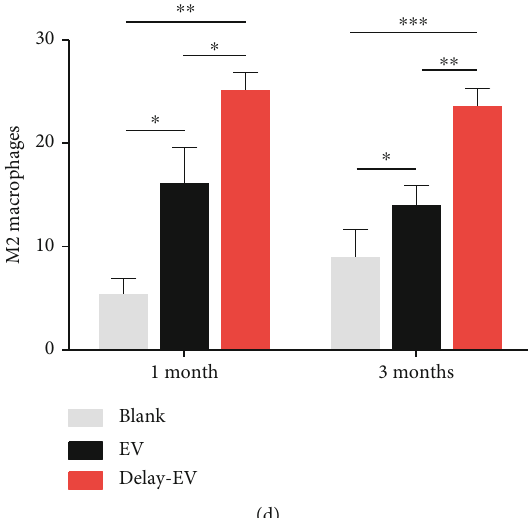
Figure 6: Immunohistochemical staining for fat transplants after 3 months. (a) Immunohistochemical staining images (CD31, Ki67, and CD206) of grafts slices taken from three groups at month 3. Scar bar = 50 μ m . Quantitative analysis of (b) CD31-positive vessels, (c) Ki67-positive cells, and (d) M2 macrophages of each group (all n = 5 ). ∗ P < 0 : 05, ∗∗ P < 0 : 01, and ∗∗∗ P < 0 : 001